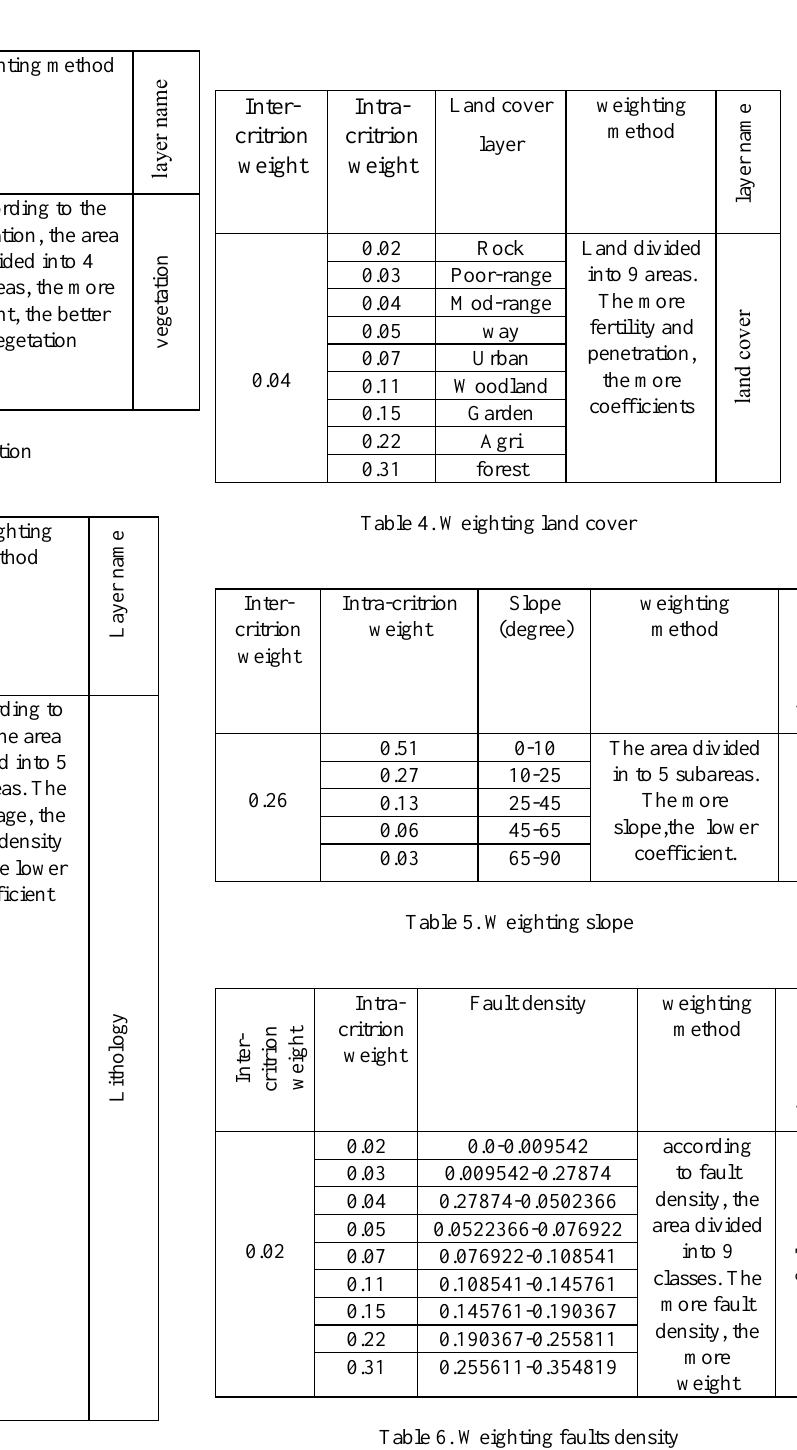
Table 3. Weighting lithology